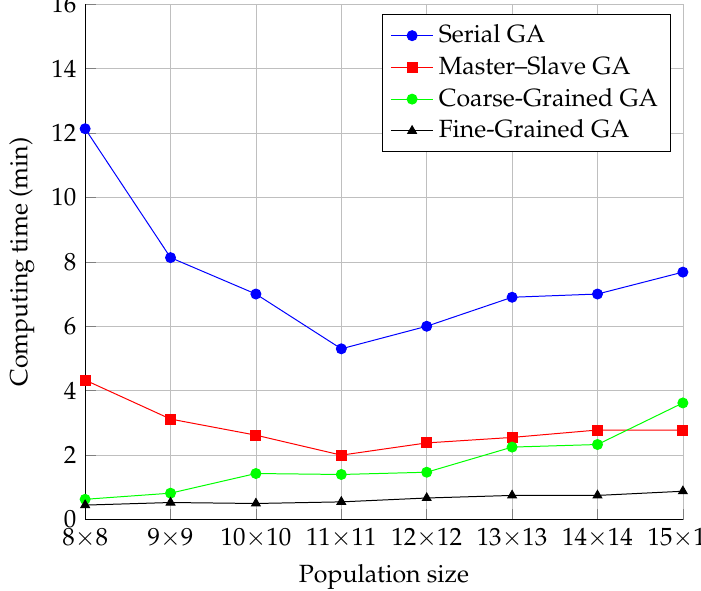
Figure 10. Comparison of the computation time of the GA